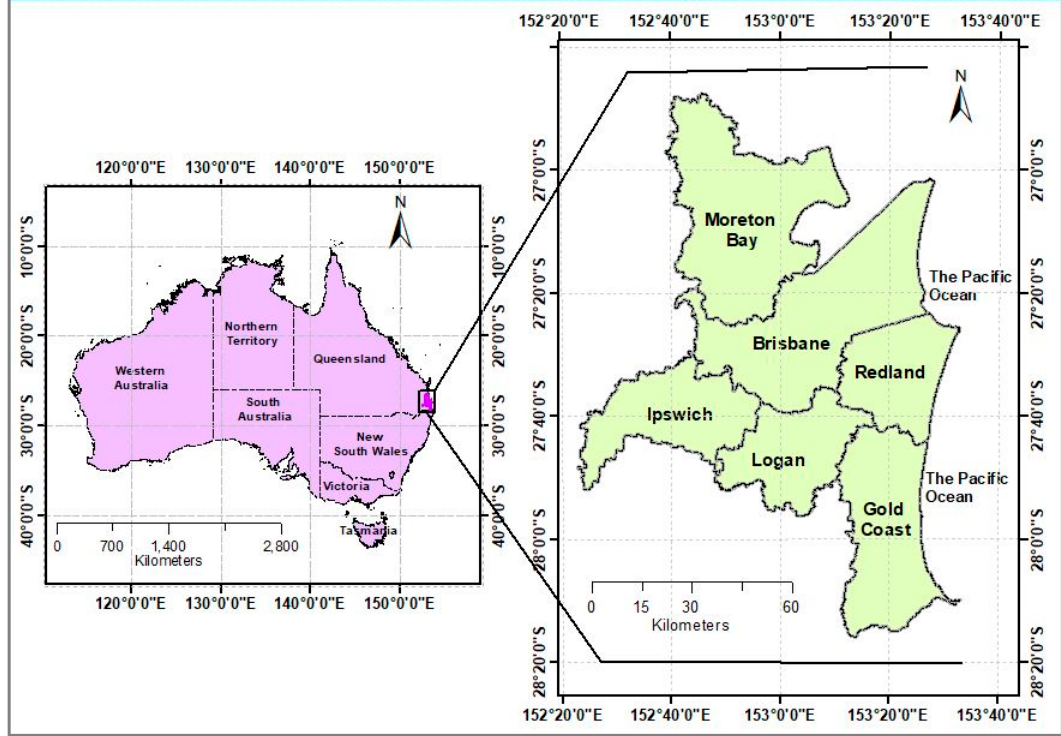
Figure 1. Location of the study area.